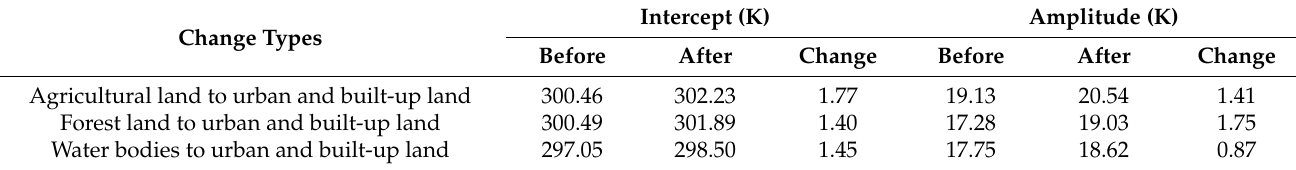
As a result, the difference values of LST in terms of intercept and amplitude are 1.77 K and 1.41 K, in converting agricultural land to urban and built-up land. Meanwhile, in the transformation of forest land to urban and built-up land, the difference values of LST in terms of intercept and amplitude are 1.40 K and 1.75 K. At the same time, in the